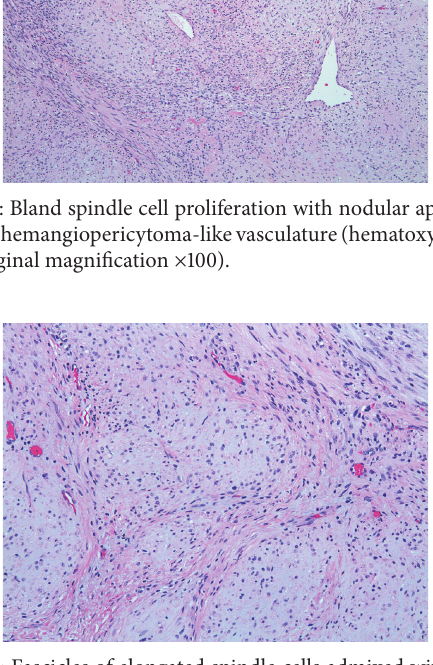
Figure 4: Fascicles of elongated spindle cells admixed with whorls of plumper pale-staining spindle cells (hematoxylin-eosin stain, original magnification × 200).